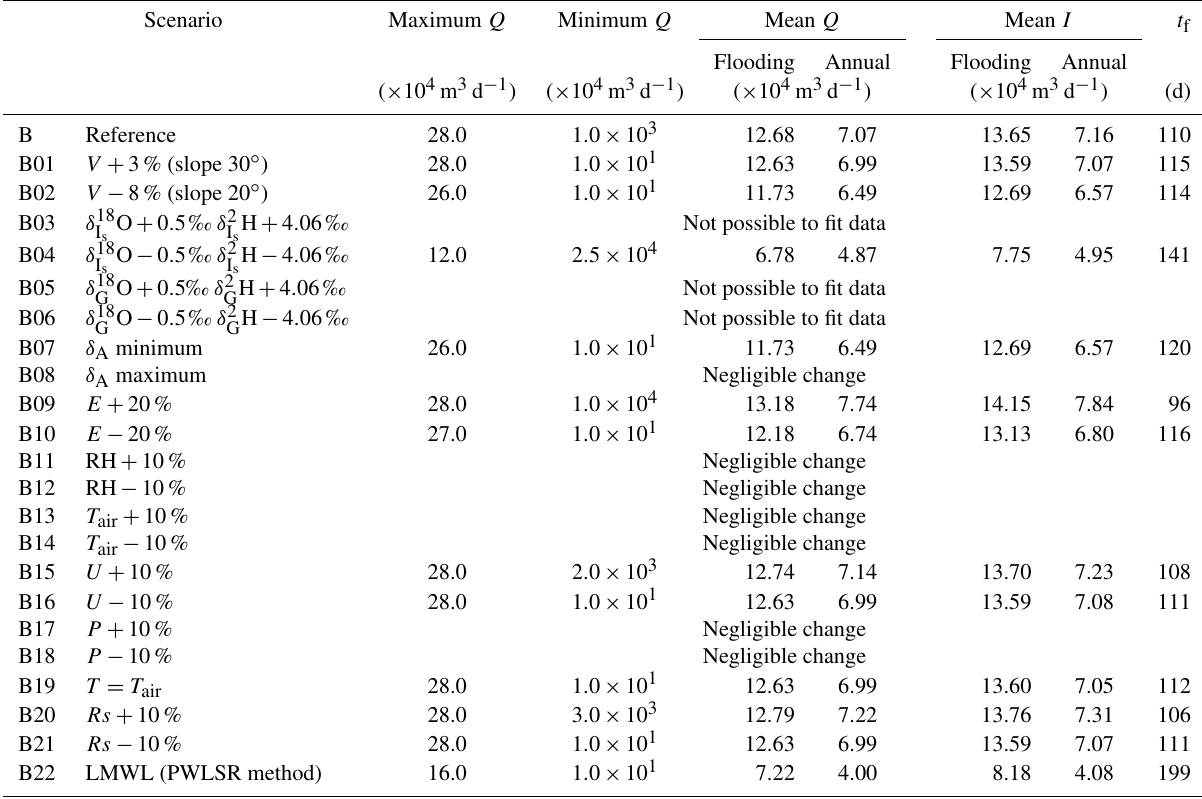
Table F2. Sensitivity analysis on the input parameters of the isotopic mass balance model for the reference scenario B. Q is the output flux from lake A, I the input flux, and t f the mean flushing time by